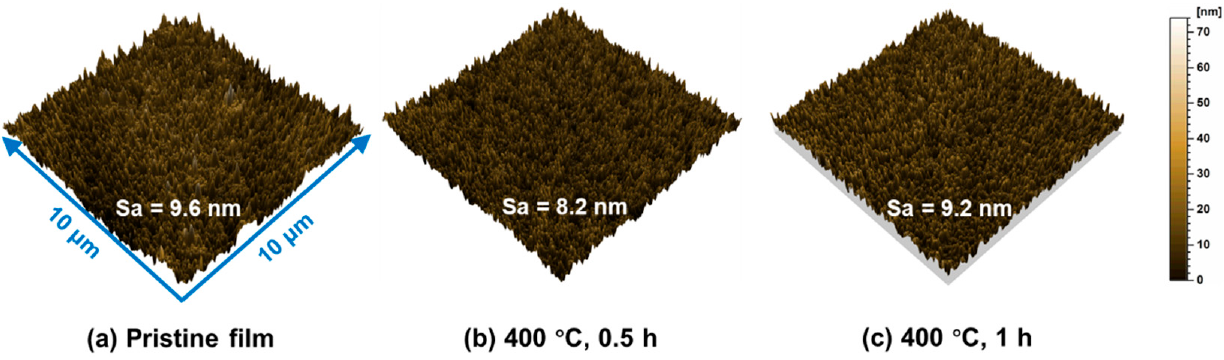
Figure 10. Surface AFM images and roughness of the WTi alloy film with 6.8 at.% Ti after vacuum annealing at 400 °C for 0~1 h.